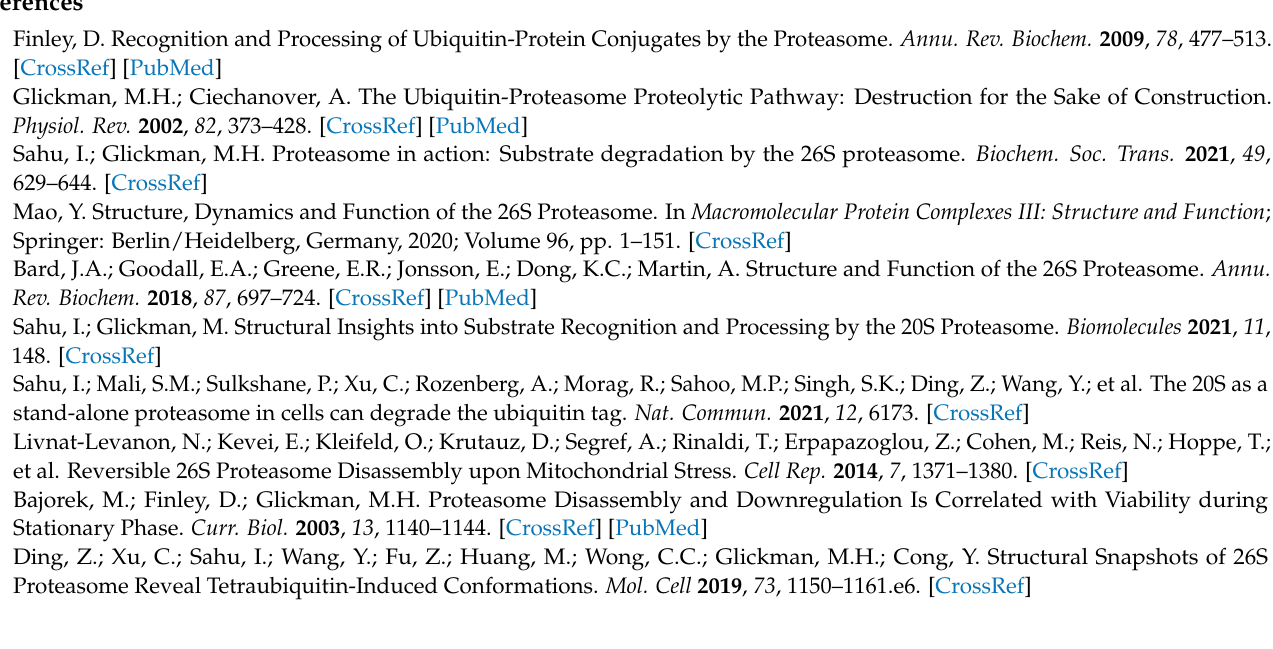
Figure S2: YD(X) motifs of α -subunit N-termini of human proteasome; Figure S3: YD(X) motif Interactions in closed state human 20S proteasome; Figure S4: Roughness analysis of the 20S gate area; Figure S5: Substrate interaction with Phe residue in N-terminal tail of the α 2